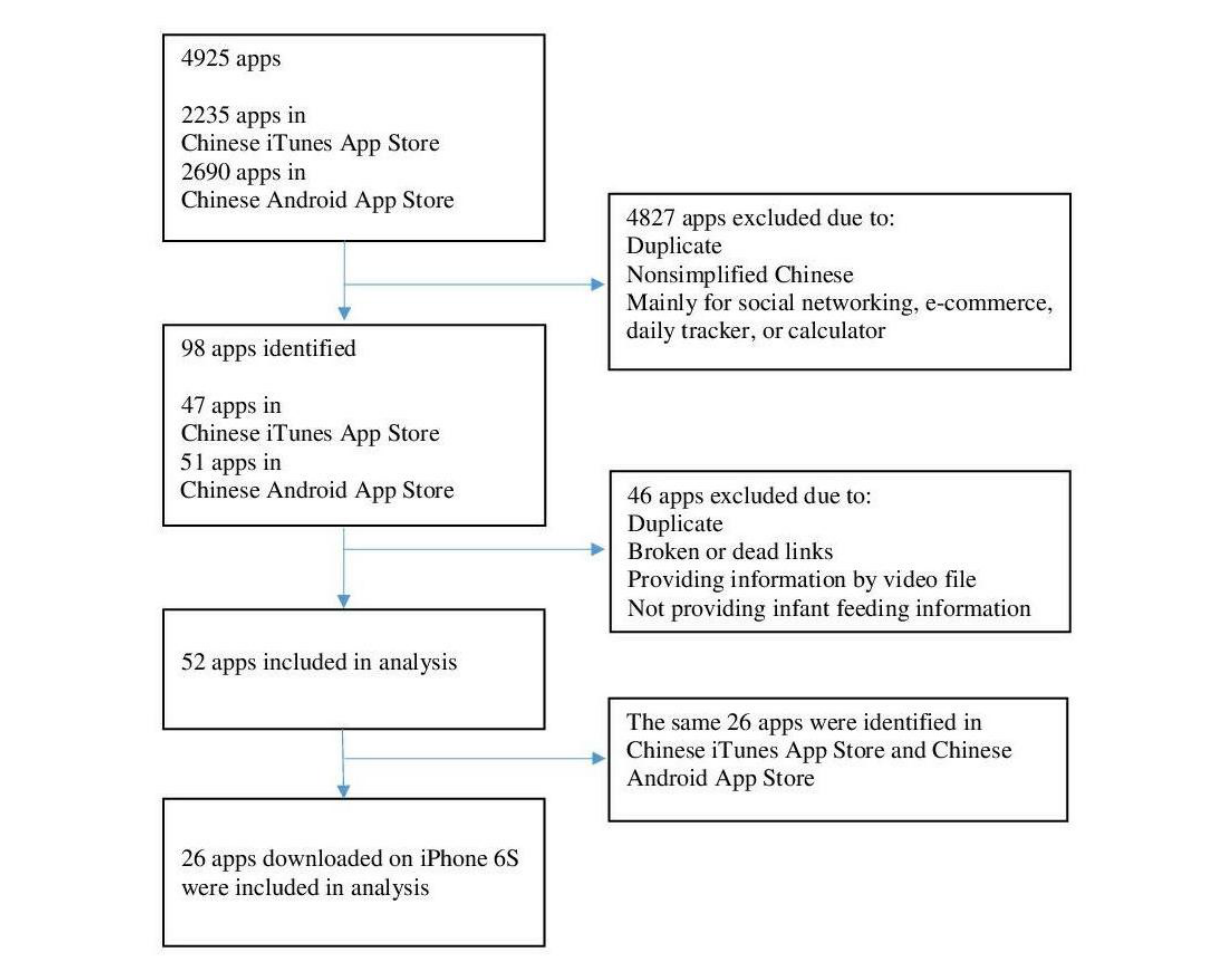
Figure 1. Flow diagram for selection of Chinese infant feeding